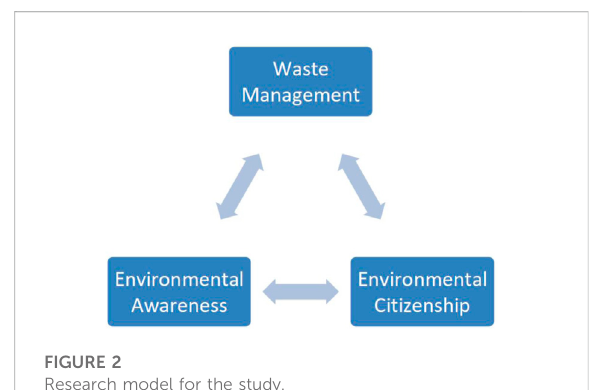
FIGURE 2 Research model for the